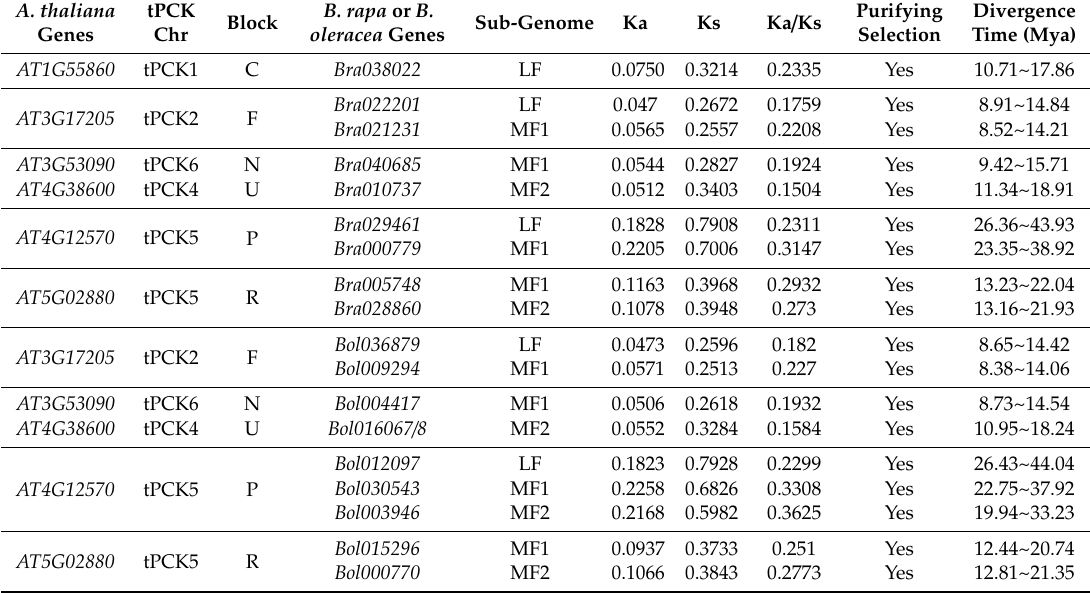
Table 1. Ka, Ks, Ka/Ks ratio and divergence time of the orthologous HECT gene pairs between Arabidopsis and Brassica species.